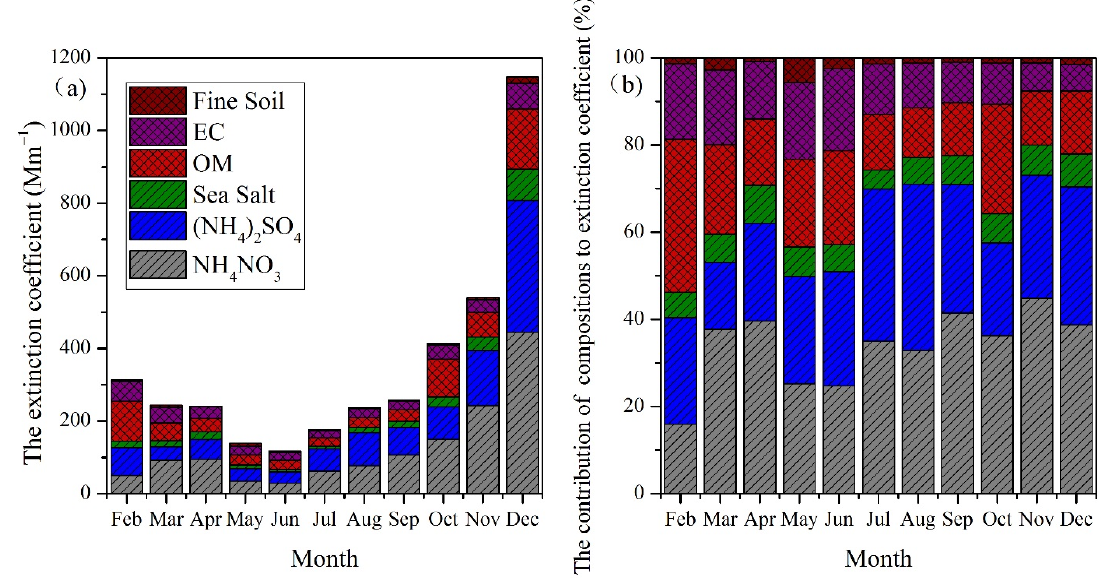
Figure 5. The monthly average extinction coefficients ( a ) and contributions ( b ) of main extinction components in PM 2.5 in Tianjin, 2015.